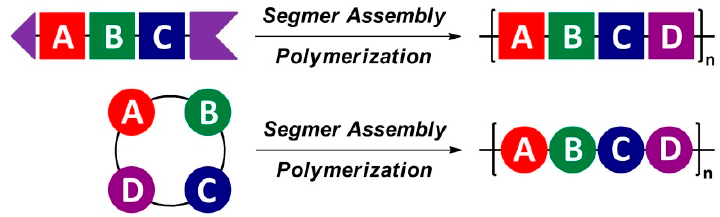
Scheme 2. Schematic illustration of segmer assembly polymerization (SAP).